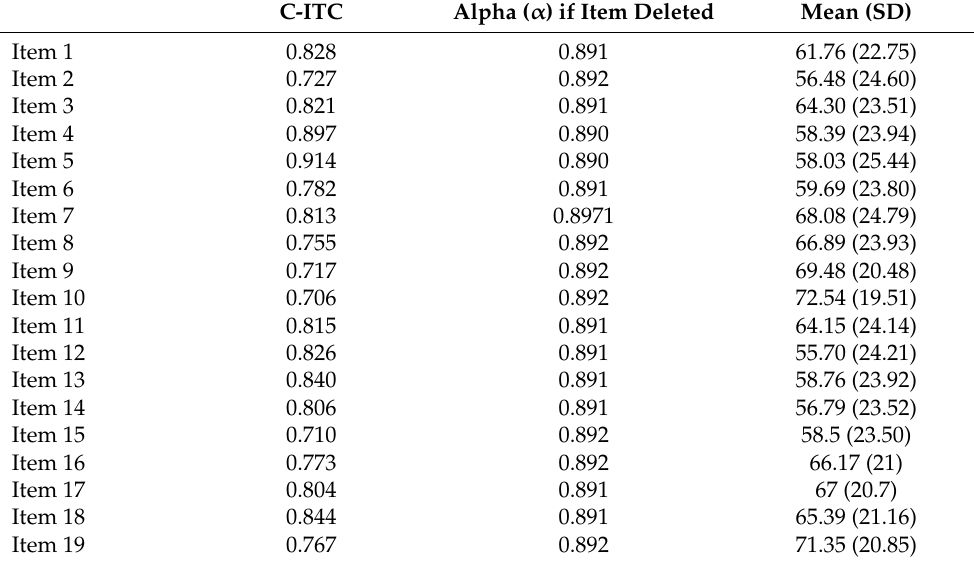
Table 4. Internal consistency results ( n = 193).